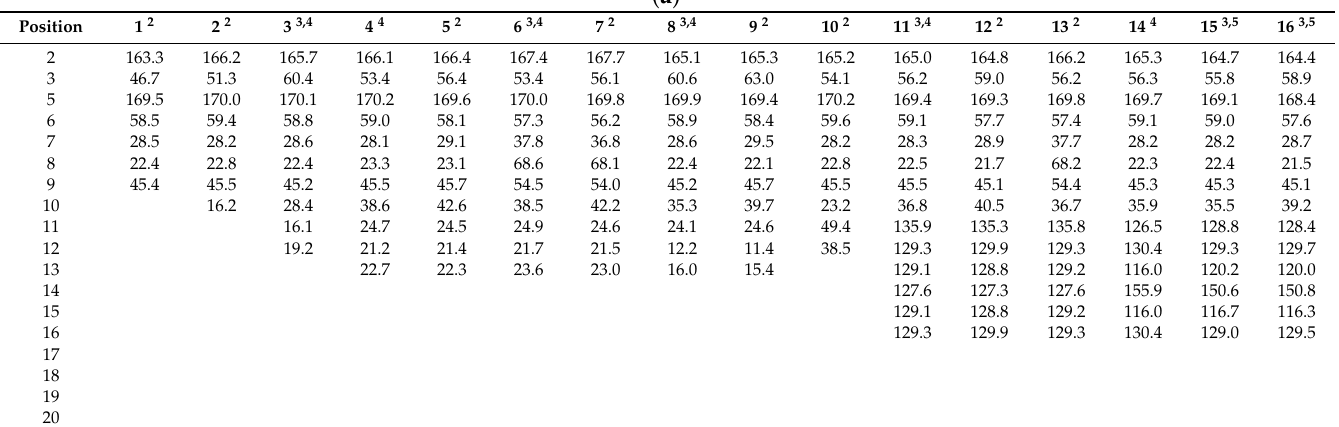
Table 2. ( a ) 13 C NMR data ( δ in ppm) 1 of compounds 1 – 16 . ( b ) 13 C NMR data ( δ in ppm) 1 of compounds 17 – 32